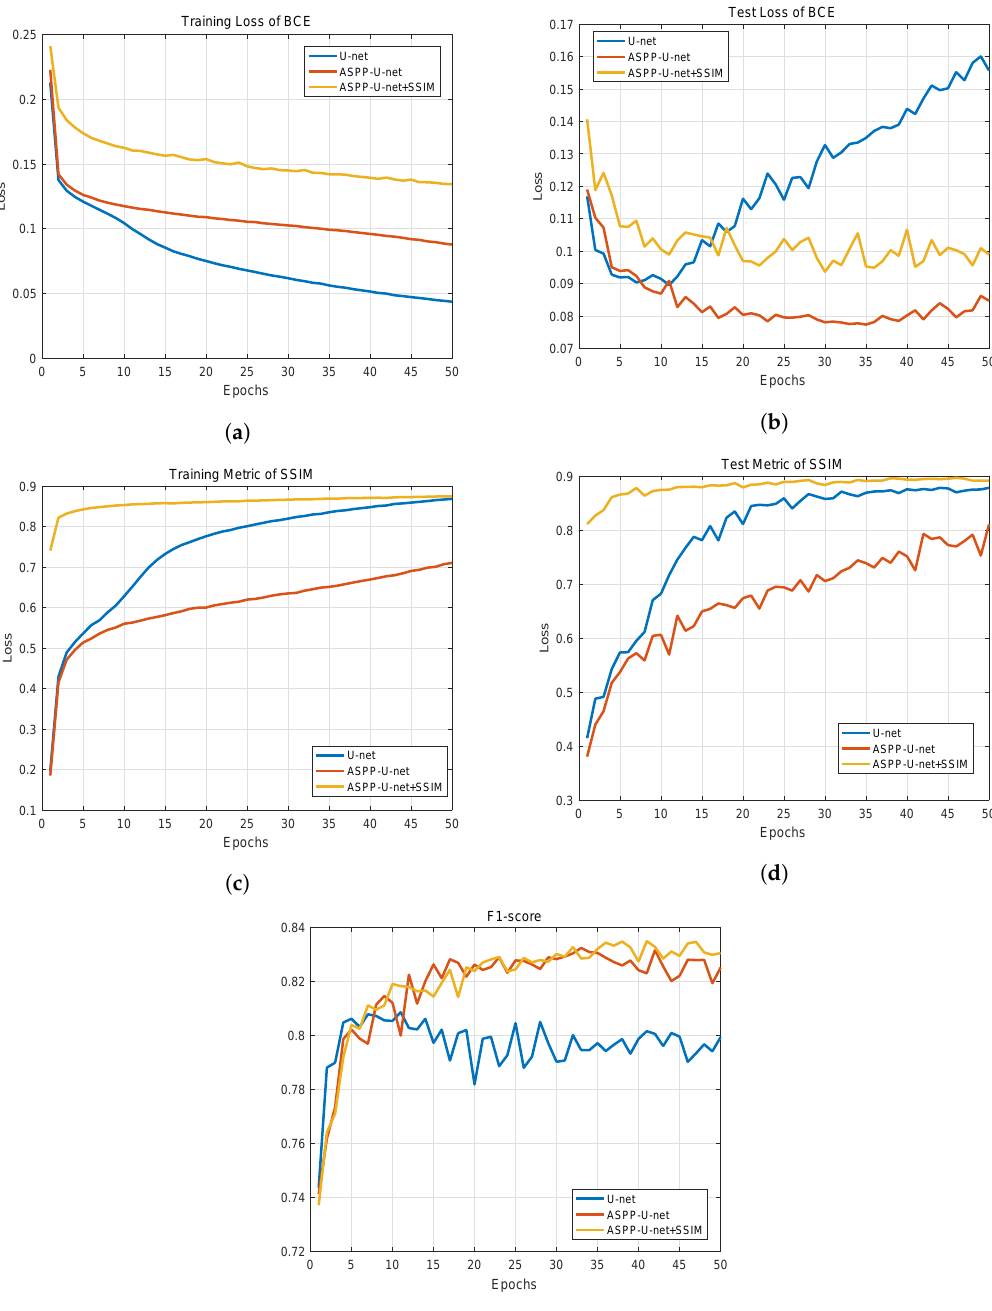
Figure 5. The training metrics of the three different experiments. ( a ) is the BCE loss of the training process, and ( b ) is the BCE loss of the test predictions. ( c ) is the SSIM metric in training process, and ( d ) is the SSIM metric of the test predictions. ( e ) is the mean F1-score of the test